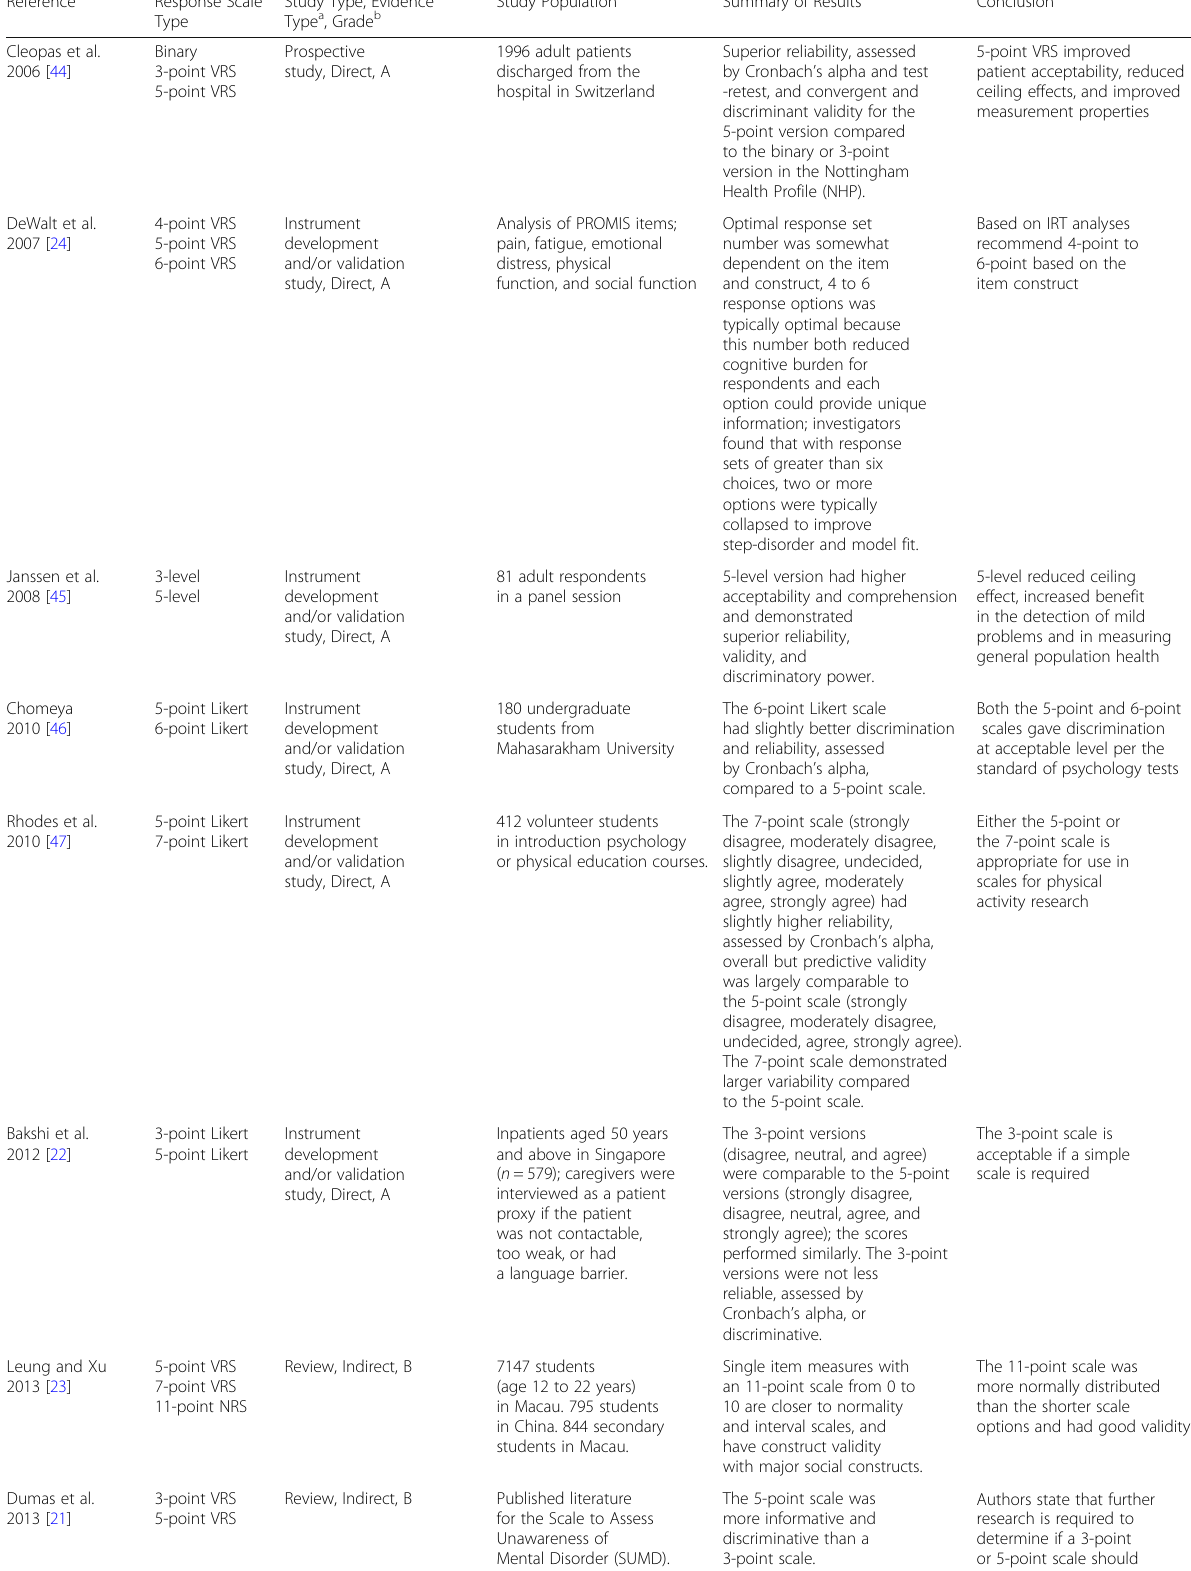
Table 4 Key studies that support response scale selection used in PRO instruments based on optimal response set number